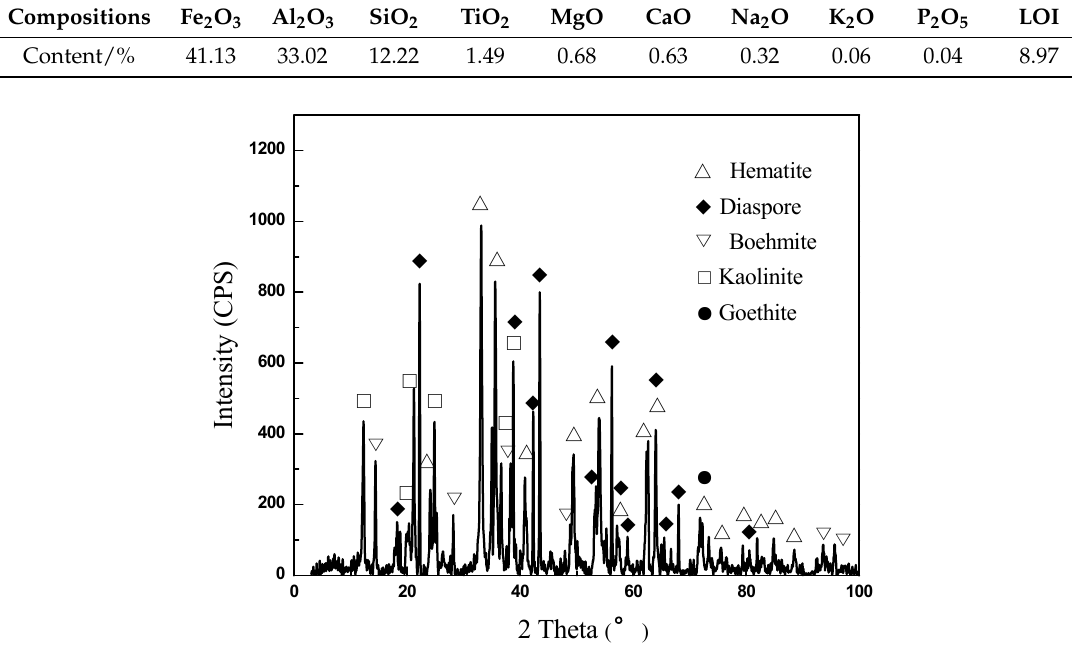
Table 1. The chemical composition of the ferric bauxite adopted.